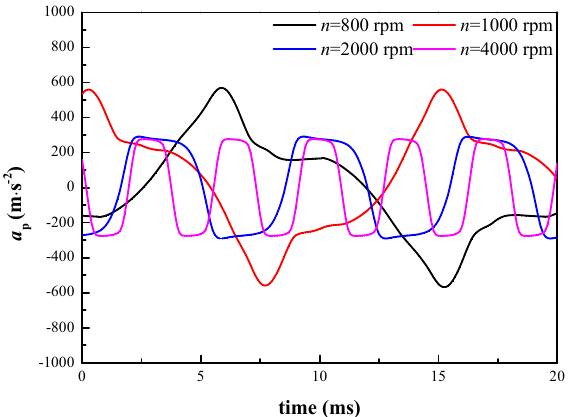
Figure 8. Velocities of different valve spool rotation speeds when the proportional flow control valve port is fully open.